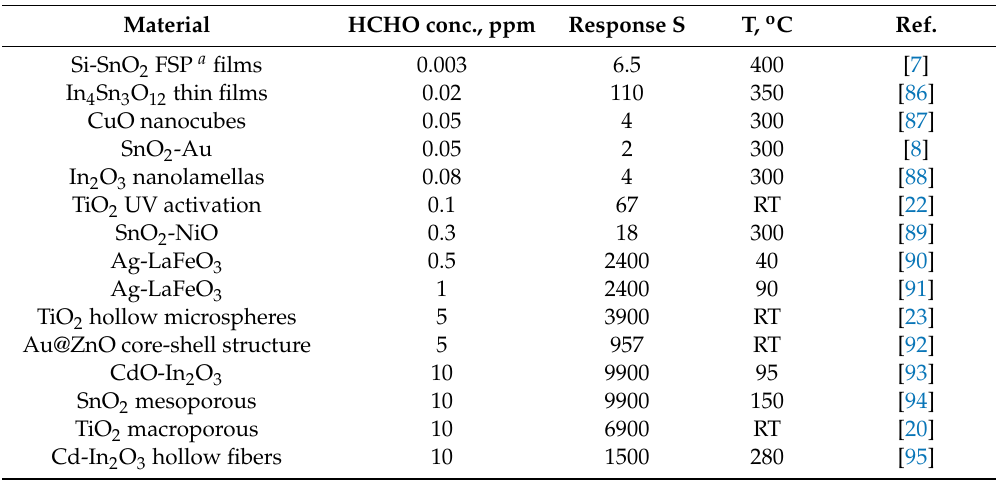
Figure 14. Cross sensitivity of SnO 2 (SnTi-0, black), SnTi-1 (red), SnTi-2 (blue) and SnTi-3 (green) nanocomposites toward HCHO (circles), benzene (squares) and acetone (triangles) at 150 °C.